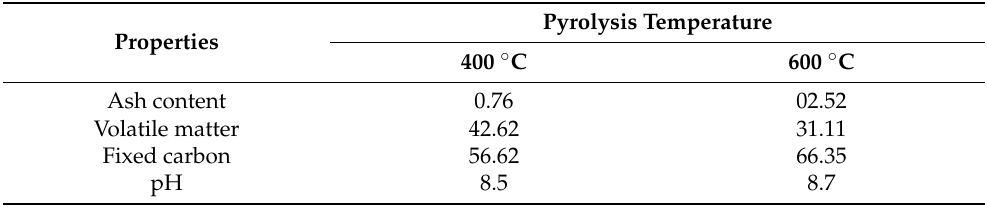
Table 1. Shorea sp. biochar properties according to previous research [52].